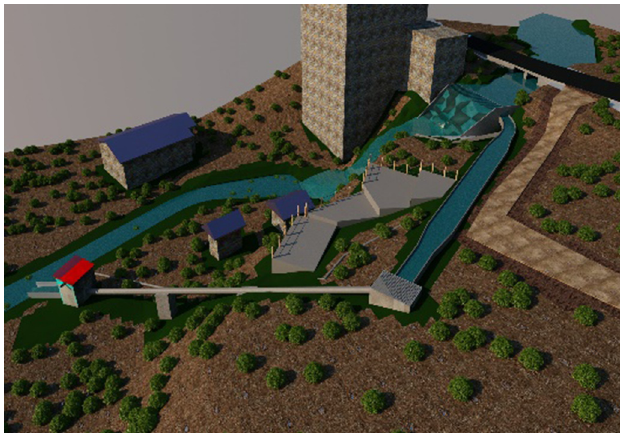
Fig. 17. 3D model of Lefock micro hydro site studied in Dschang